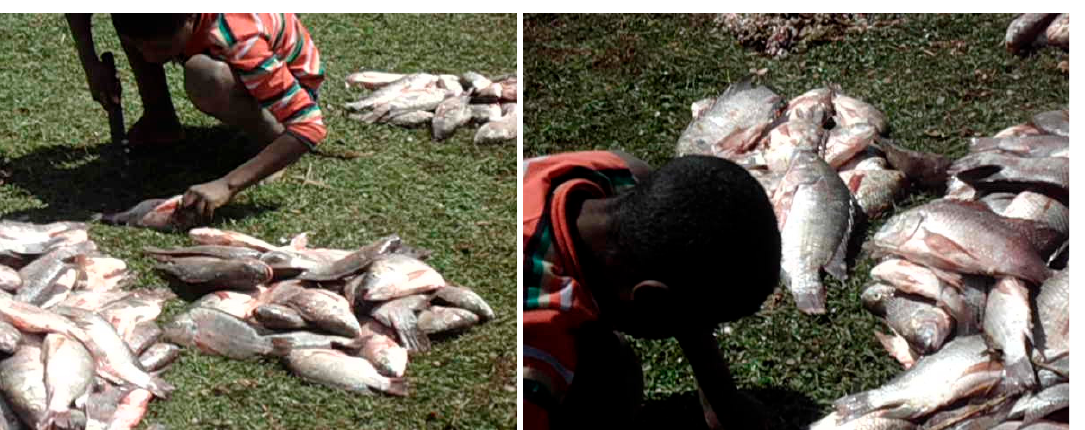
11 Table 8. Rank of wetland and Lake Tana resources. Description of Wetland Re- sources